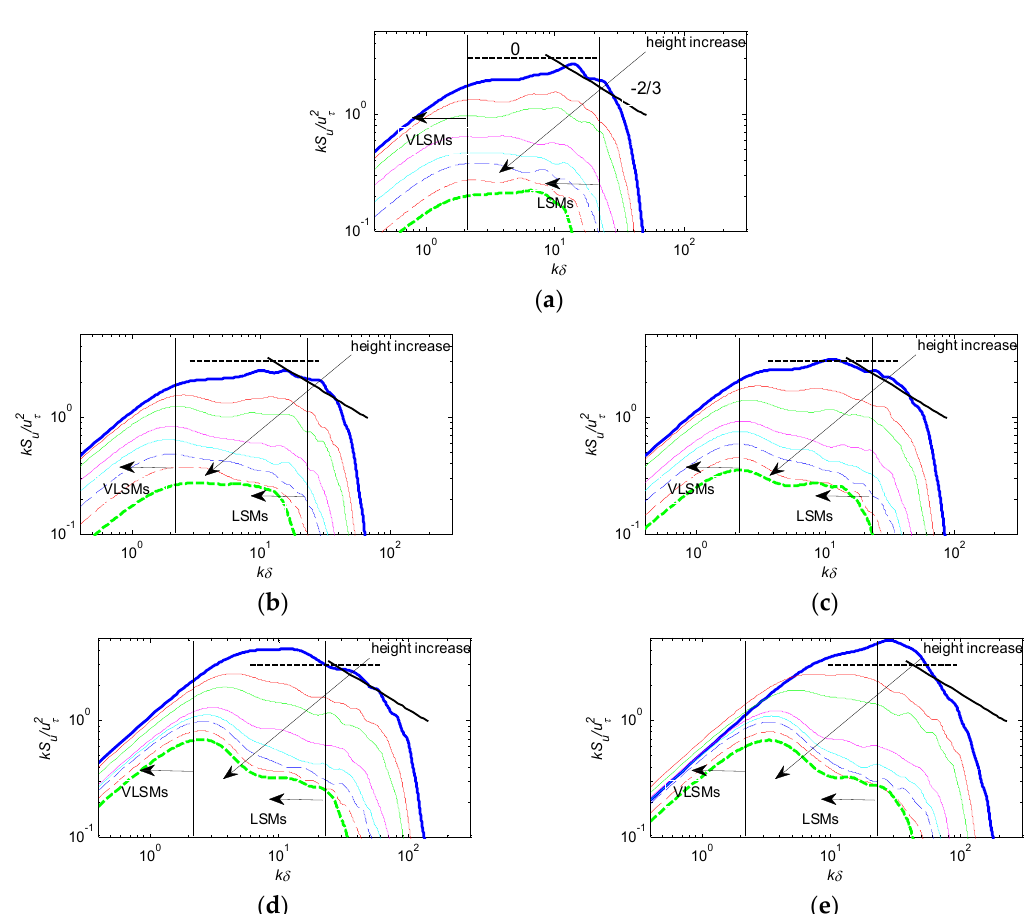
Figure 10. Pre-multiplied spectra for streamwise velocity fluctuation. ( a ) case 1, ( b ) case 2, ( c ) case 3, ( d ) case 4 and ( e ) case 5. The height indicators for each graph are the same as those shown in Figure 9a, that is, 7.5 m, 27.5 m, 47.5 m, 67.5 m, 87.5 m, 107.5 m, 127.5 m, and 147.5 m.